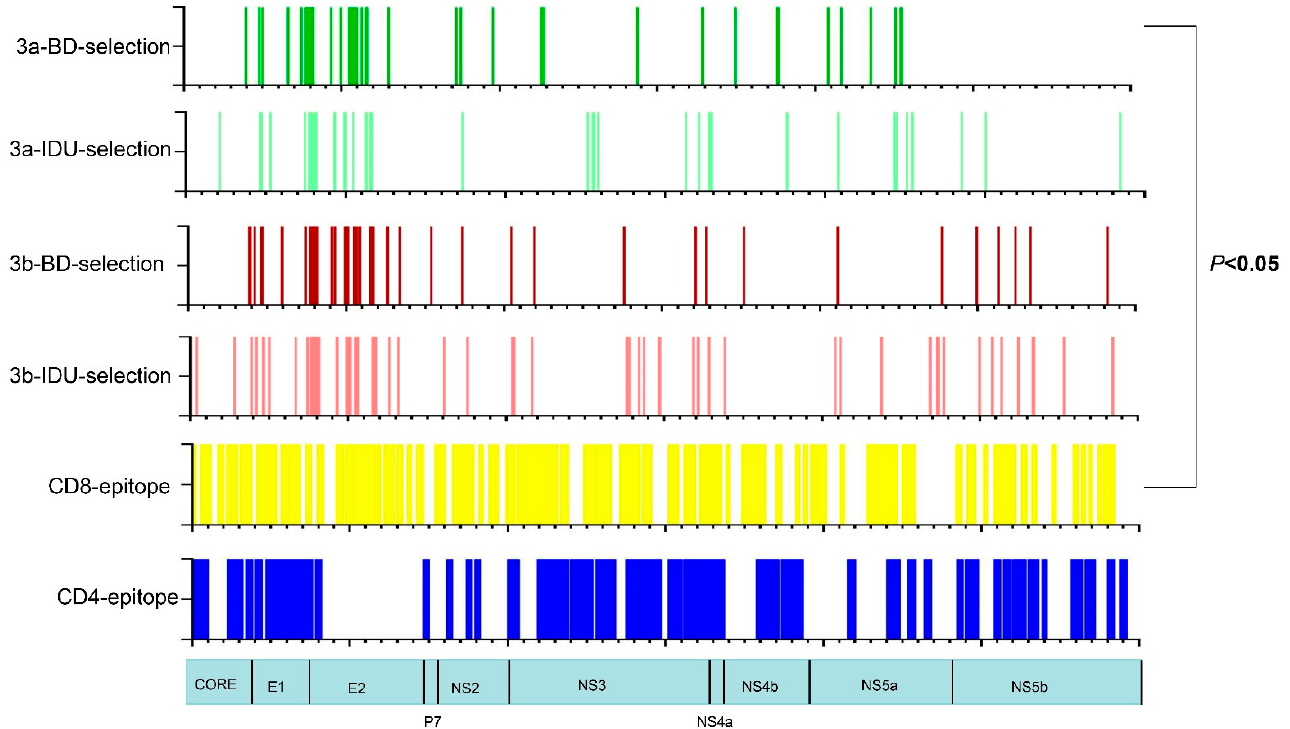
Figure 6. Map of the HCV GT-3a-BDs (Dark green), GT-3a-IDUs (Light green), GT-3b-BDs (Dark red), and GT-3b-IDUs (light red), indicating the locations of PSSs, CD8 T cell epitopes (yellow), and CD4 T cell epitopes